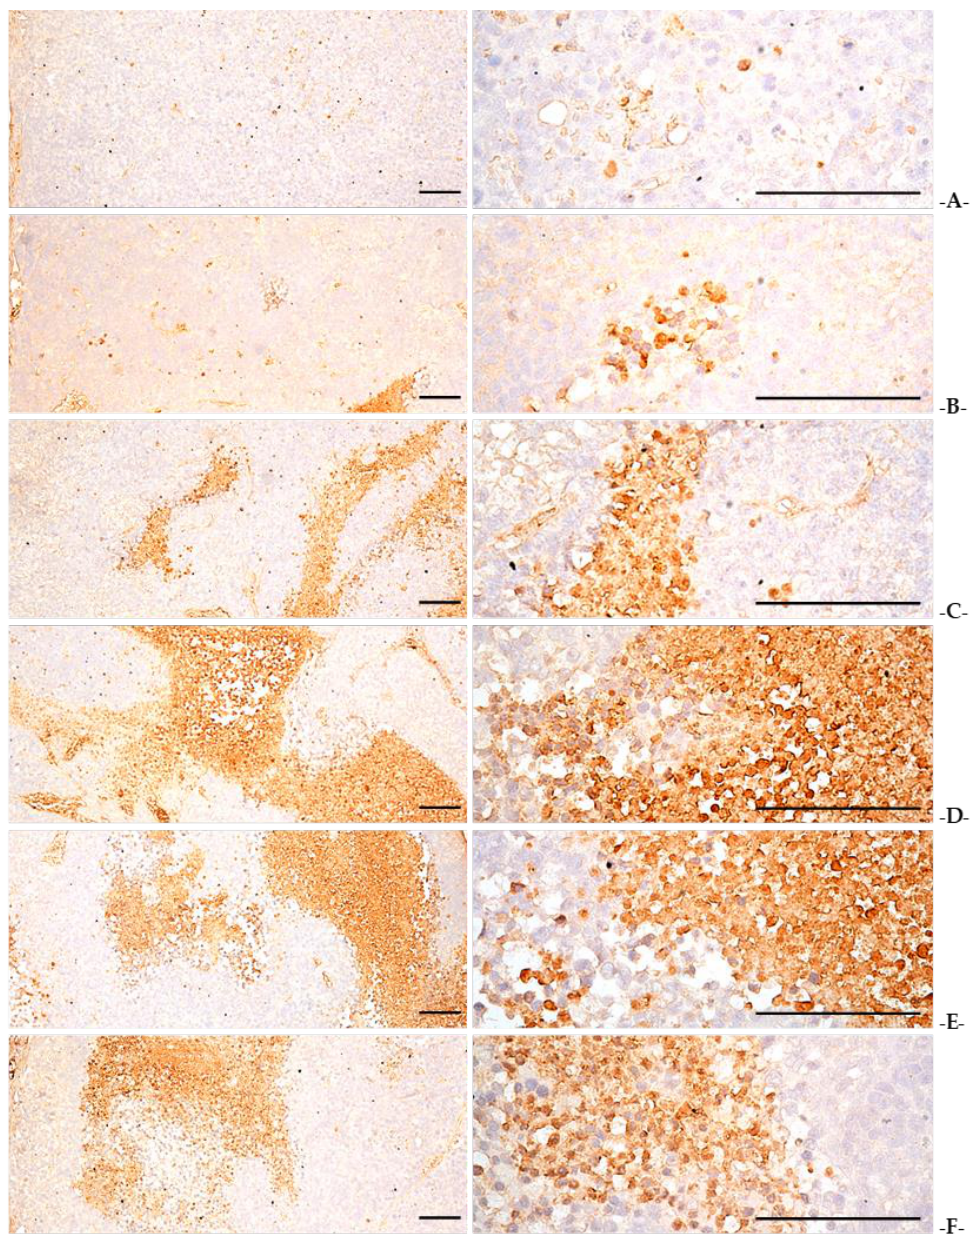
Figure 11. Representative iNOS immunoreactivities of the tumor masses taken from NCI-H520 tumor cell xenograft mice. ( A ) = Tumor-bearing control; ( B ) = 120 mg/kg-gefitinib-single-treated rodents; ( C ) = 400 mg/kg-SKOG-single-treated rodents; ( D ) = gefitinib 120 mg/kg and SKOG 400 mg/kg; ( E ) = gefitinib 120 mg/kg and SKOG 200 mg/kg; ( F ) = gefitinib 120 mg/kg and SKOG 100 mg/kg. AR = Adenophorae Radix; KOG = Kyeongokgo ; SKOG = sasam-Kyeongokgo . iNOS = inducible nitric oxide synthase. All avidin- biotin complex (ABC) methods. Scale bars = 100 μm.